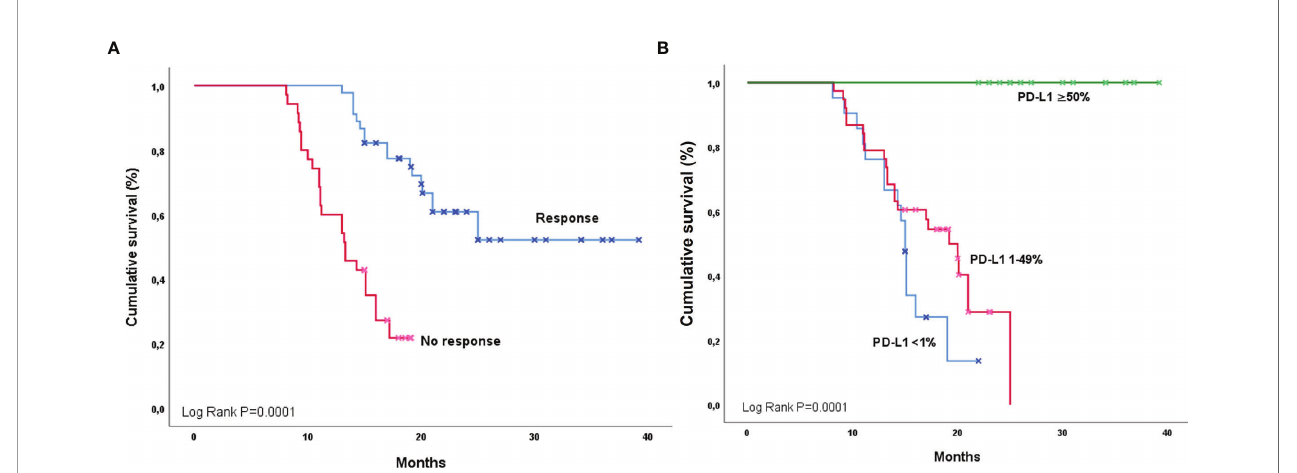
FIGURE 2 | Overall survival among Hispanics according to response (A) and PD-L1 expression